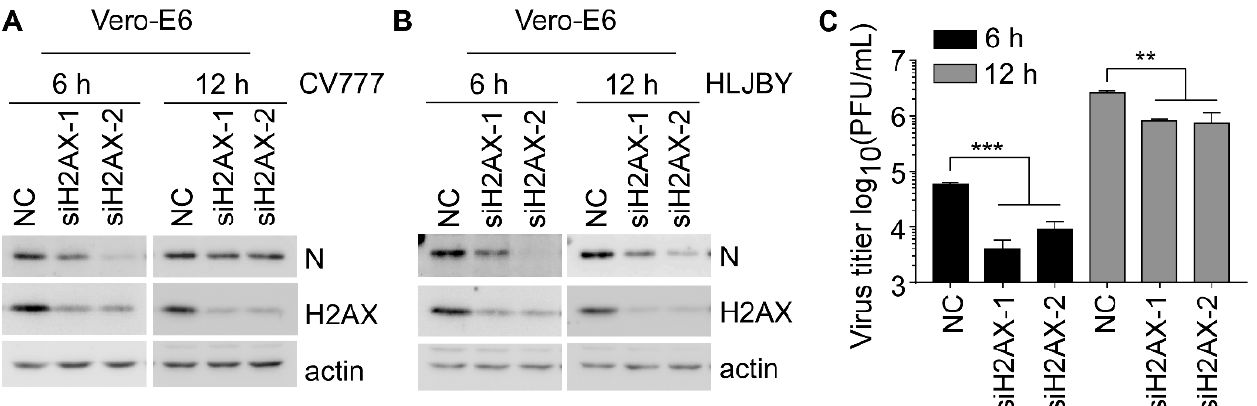
Figure 7. Silencing H2AX decreases PEDV replication. ( A , B ) Western blots were prepared with extracts from Vero-E6 cells transiently transfected with 50 nM scramble or H2AX siRNA for 48 h, followed by 1 MOI CV777 ( A ) or HLJBY ( B ) infection for 6 and 12 h. ( C ) Western blots were prepared with extracts from Vero-E6 cells transfected with 50 nM scramble or H2AX siRNA for 48 h, followed by 1 MOI CV777 infection for 6 and 12 h. The cells and supernatants were collected for PFU assay (* p < 0.05; ** p < 0.01; *** p < 0.001).